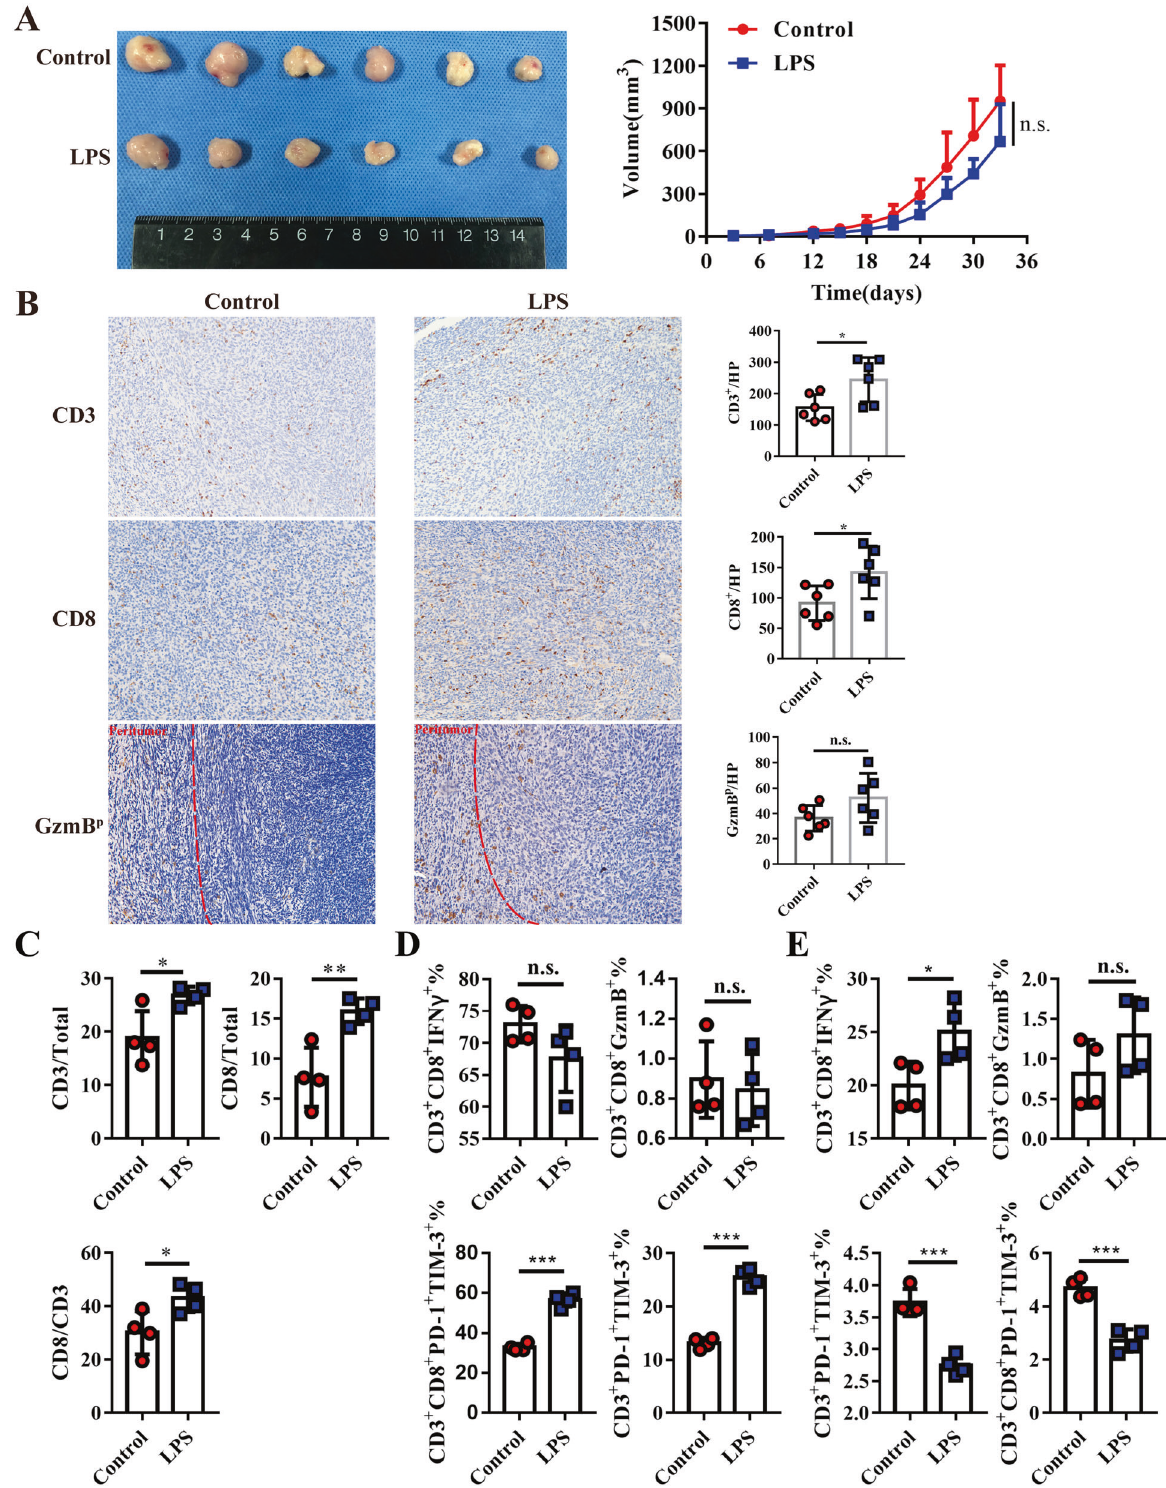
Fig. 2 LPS induced systemic immune activation but also promoted TILs exhaustion in tumor tissue. A the photograph (left) and growth curve of subcutaneous tumor tissue were implanted into C57BL/6 and received LPS administration (100 µg/kg/3 days) or PBS as control ( n = 6). B CD3, CD8, and GzmB were stained in the LPS and control groups. C fl owcytometry analyzed the in fi ltration of TILs in murine Panc02 tumor tissue. GzmB, IFN- γ , PD-1, and TIM-3 phenotypes were used to evaluate the cytotoxicity or exhaustion of TILs ( D ) or spleen-derived T cells ( E ) by fl ow